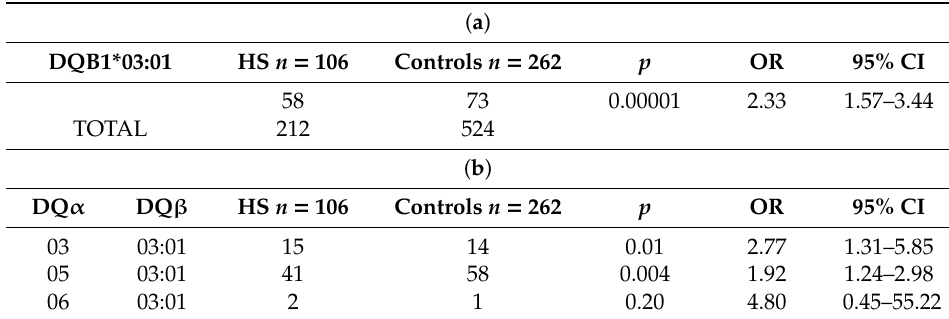
Table 3. Distribution of DQB1*03:01 allele in HS patients and healthy controls and analysis of the DQB1*03:01 frequencies found in the di ff erent heterodimer molecules.